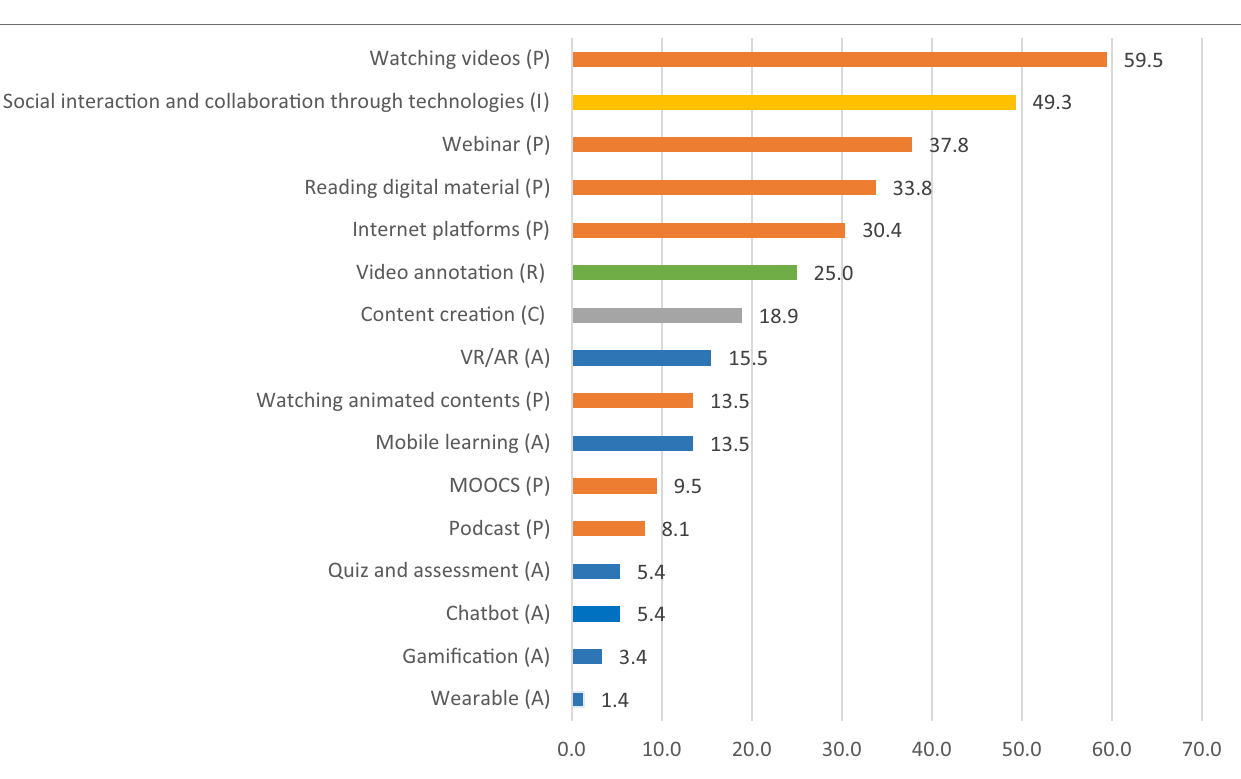
FIGURE 3 | Digital technologies adopted in organised informal learning. Each colour indicates one of the approaches: orange = passive; blue = active; green = reflective; grey = constructive; yellow =